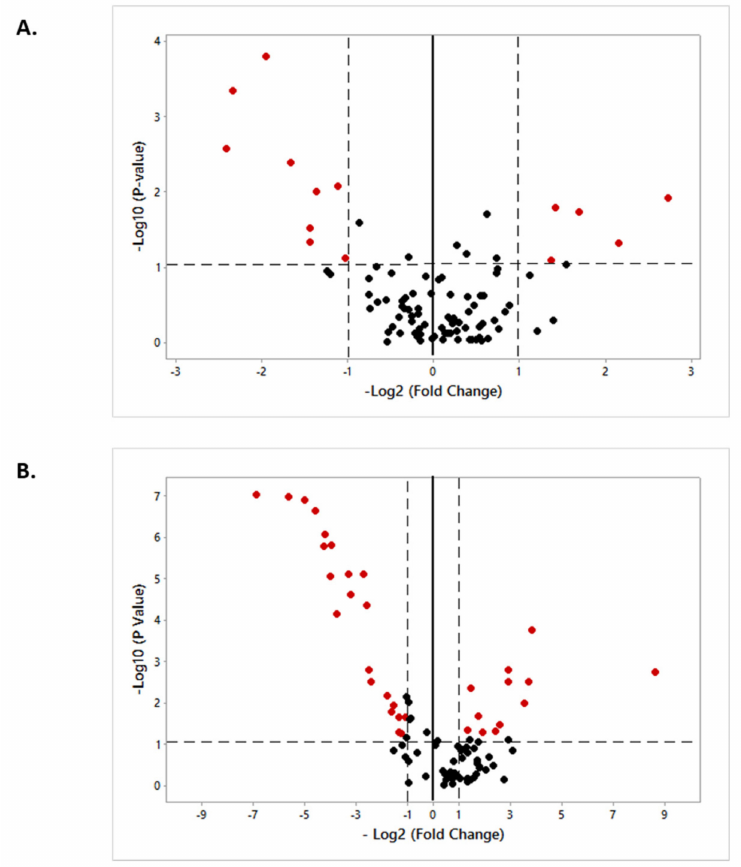
Figure 4. Volcano plot showing the ampulla (Panel ( A ); n = 6 samples per group) and isthmus (Panel ( B ); n = 6 samples per group) microRNA abundance of LF-LCL and SF-SCL groups, in terms of the differentially expressed microRNAs. SF-SCL/LF-LCL ratio was used to calculate-Log2 (Fold